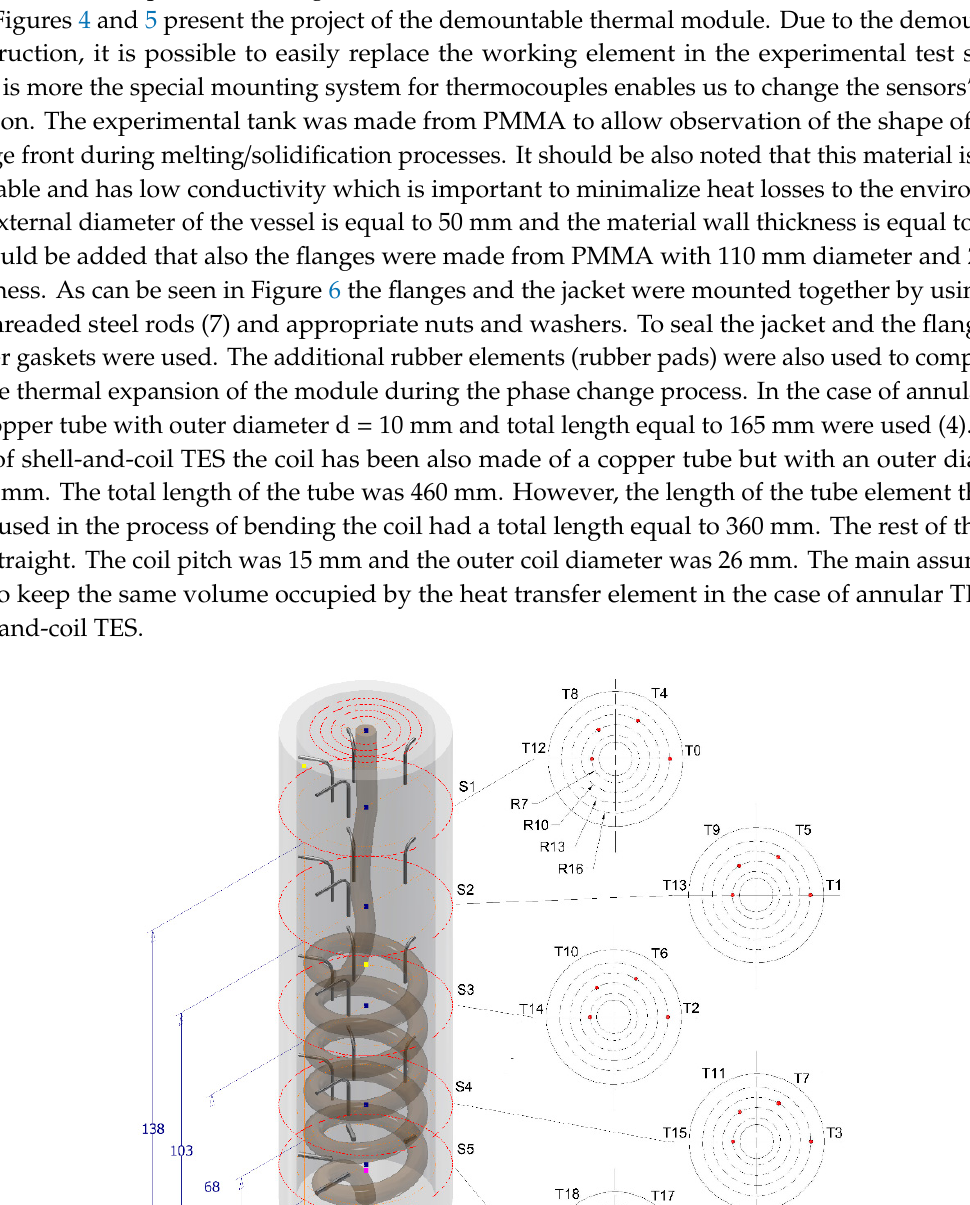
Figure 5. Arrangement of temperature sensors inside the experimental module with a straight working element: S1 to S5 surfaces in subsequent cross-sections.